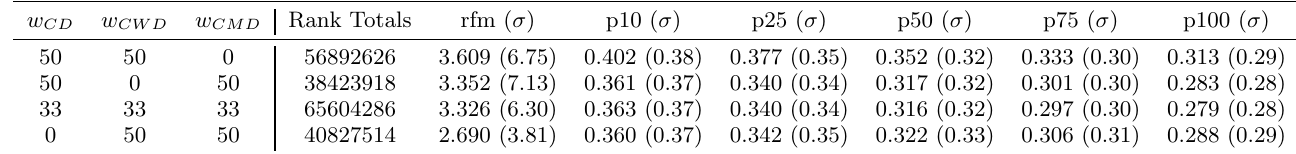
Table 5: Results (Average per day and Standard Deviation)